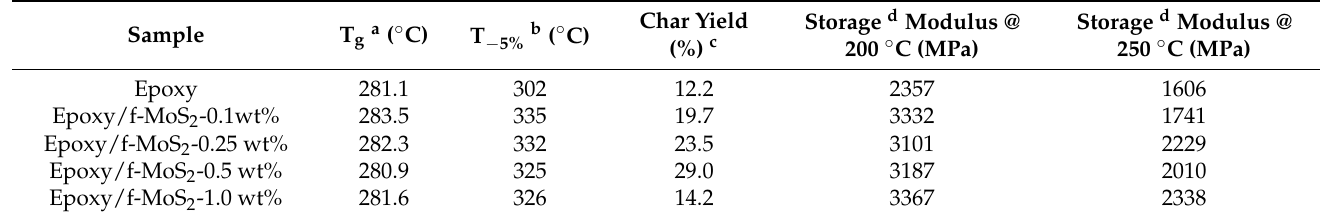
Table 1. Thermomechanical properties of the Epoxy and Epoxy/f-MoS 2 nanocomposites.